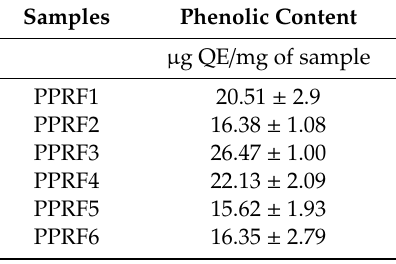
Table 1. Total phenolic content (TPC) of di ff erent fractions of L. tetragona methanolic